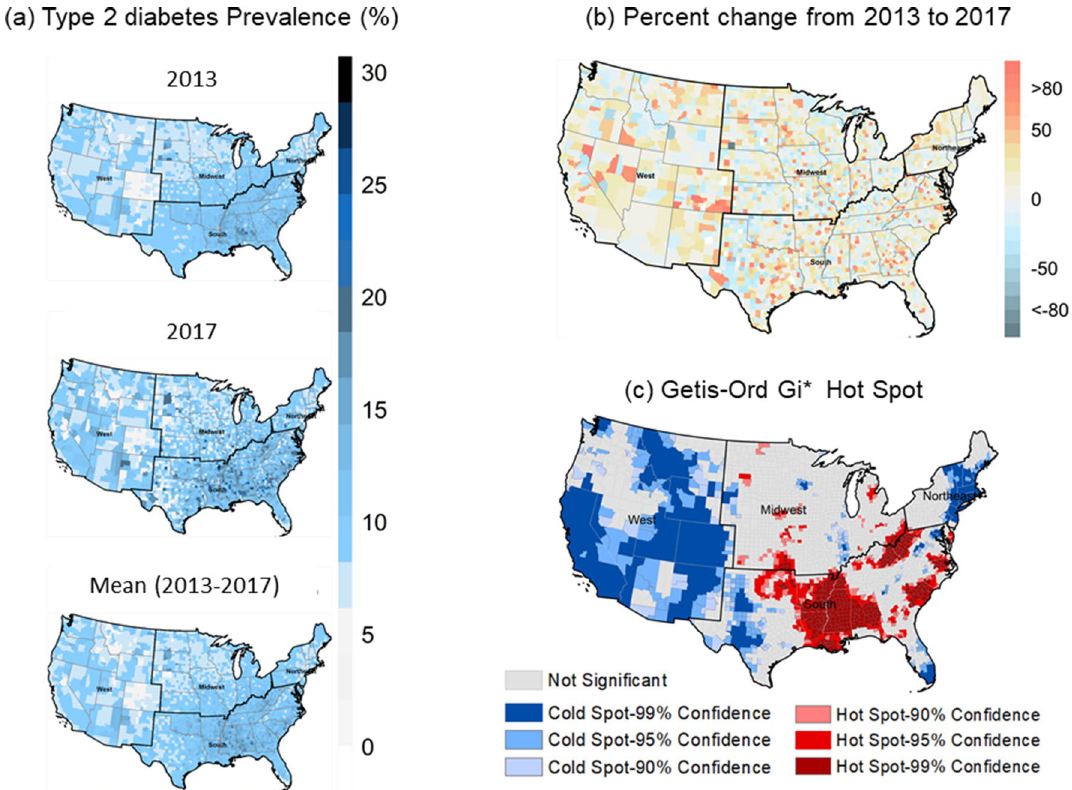
Figure 1. County-level prevalence maps of ( a ) T2D for the years 2013–2017 and 5-year average (2013–2017); ( b ) percent change from years 2013–2017; and ( c ) the geographical clusters of counties from Getis-Ord Gi* statistics of T2D. Maps in ( a ) and ( b ) were created in the R (4.0.0) Statistical Computing Environment 39 . Getis- Ord Gi* Hot Spot map was created in ArcGIS Desktop version 10.6.1 35